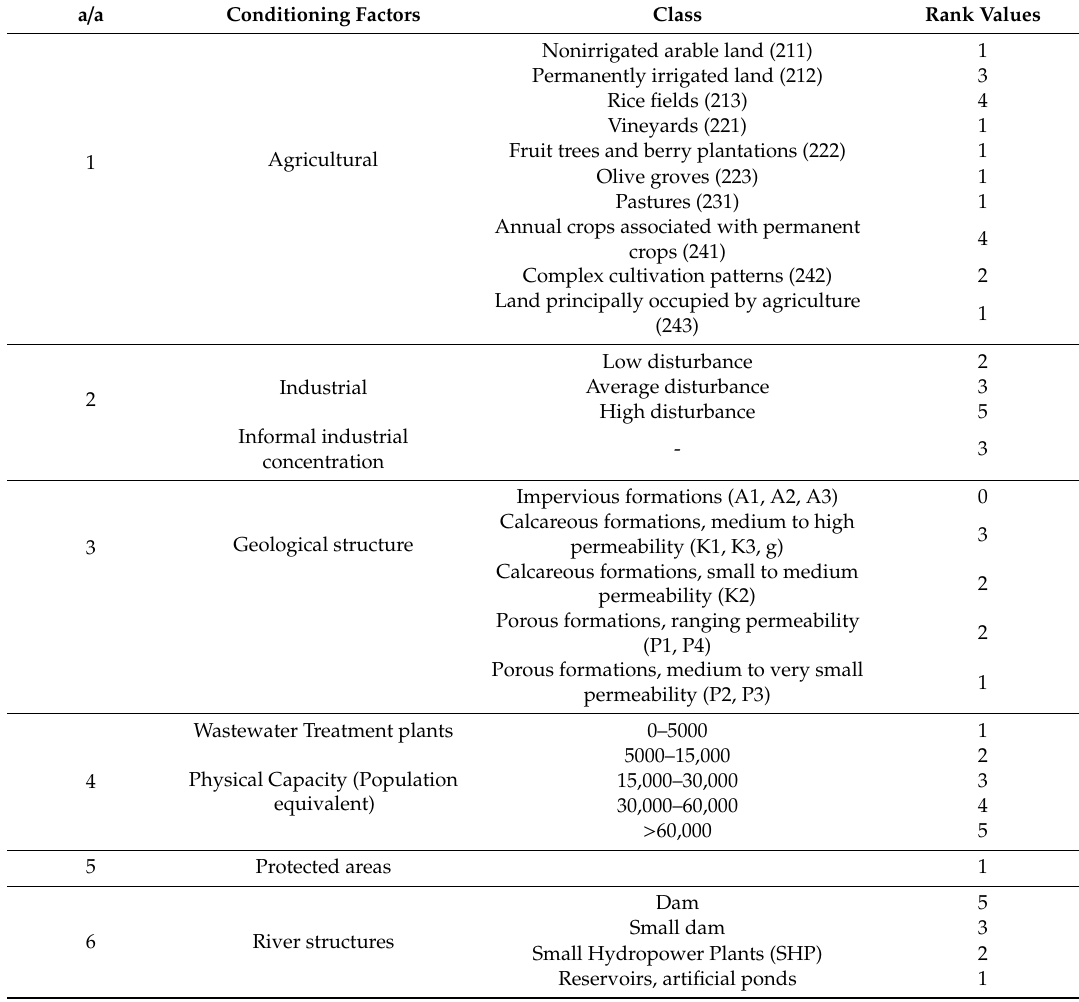
Table 5. Weights of the factors increasing the need for monitoring of water quality parameters of rivers in